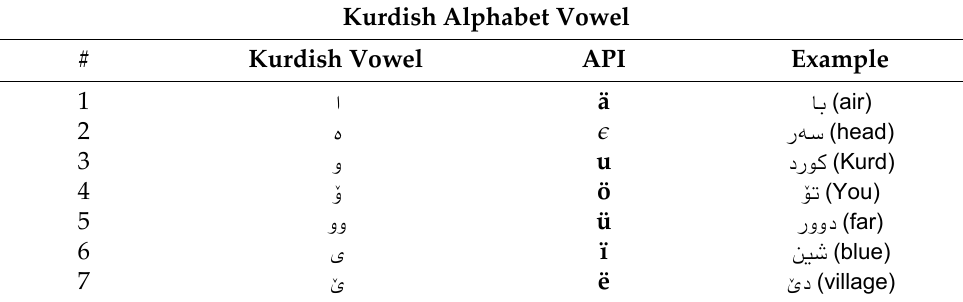
Table 6. Vowel letters in Kurdish